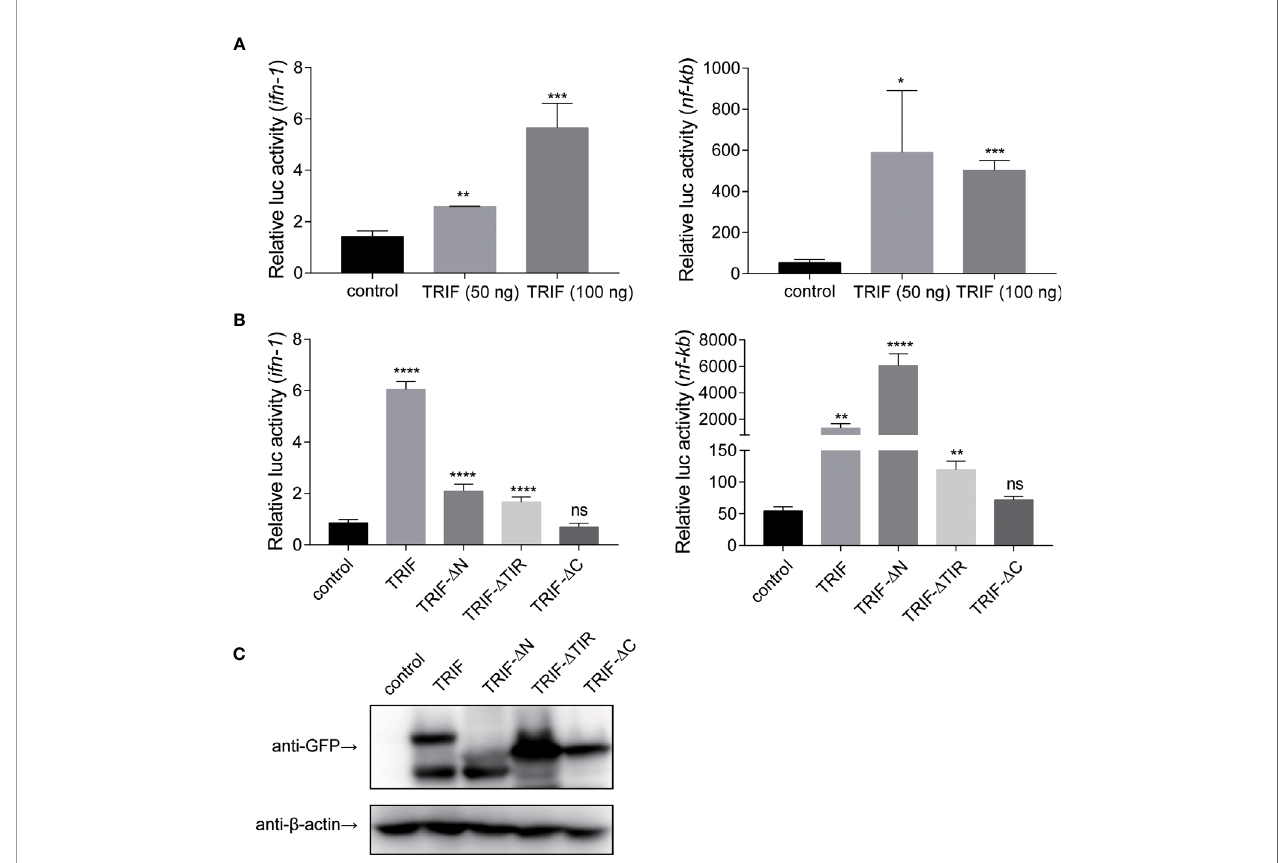
FIGURE 7 | Carp TRIF enhances the promoter activities of ifn and nf- k b through the C-domain. (A) 293T cells were transfected with pEGFP-N1 (control) or different amounts (50 and 100 ng) of carp TRIF-EGFP together with ifn-1 or nf- k b promoter luciferase reporter vector and pRL-TK. After transfection for 48 h, Fire fl y and Renilla luciferase activities were measured. (B) 293T cells were transfected with the indicated plasmid. After transfection for 48 h, Fire fl y and Renilla luciferase activities were measured. (C) 293T cells were seeded in 6-well plates and transfected with the pEGFP-N1 (control) and different mutants of carp TRIF (TRIF- △ N- EGFP, TRIF- △ TIR-EGFP, or TRIF- △ C-EGFP) for 48 h. The cell lysates were subjected to Western blot analysis with anti-GFP and anti- b -actin Abs. All data represented the means ± SD (n = 3) from three independent triplicate experiments, * P < 0.05, ** P < 0.01, *** P < 0.001, **** P < 0.0001 and ns, no signi fi